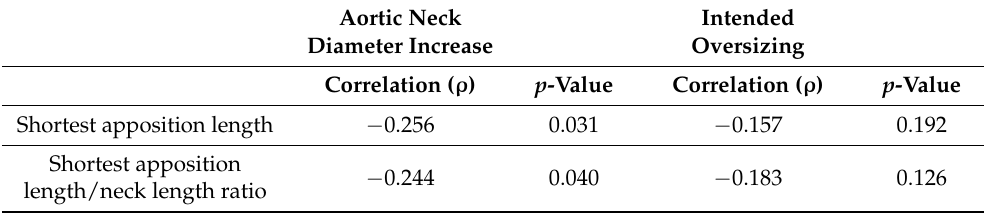
Spearman correlation between shortest apposition length and shortest apposition length/neck length ratio with neck diameter increase and the intended oversizing at 10 mm distal from the lowest renal artery